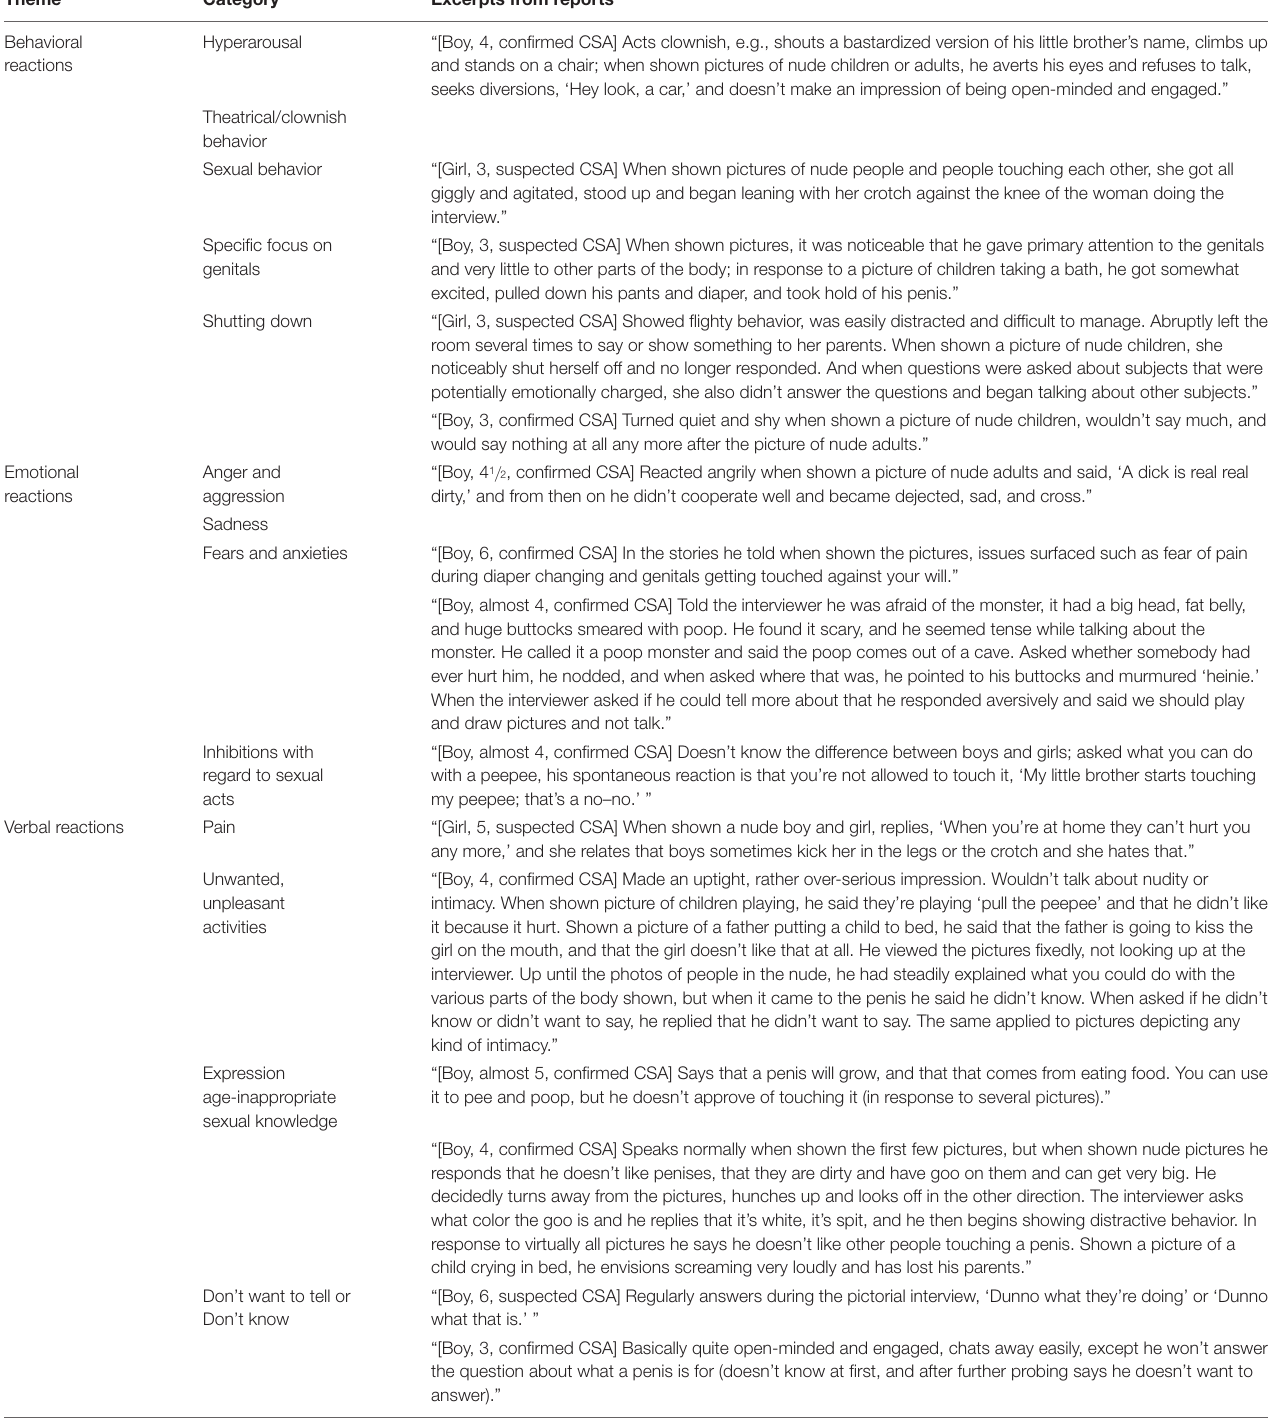
TABLE 5 | Themes derived from child